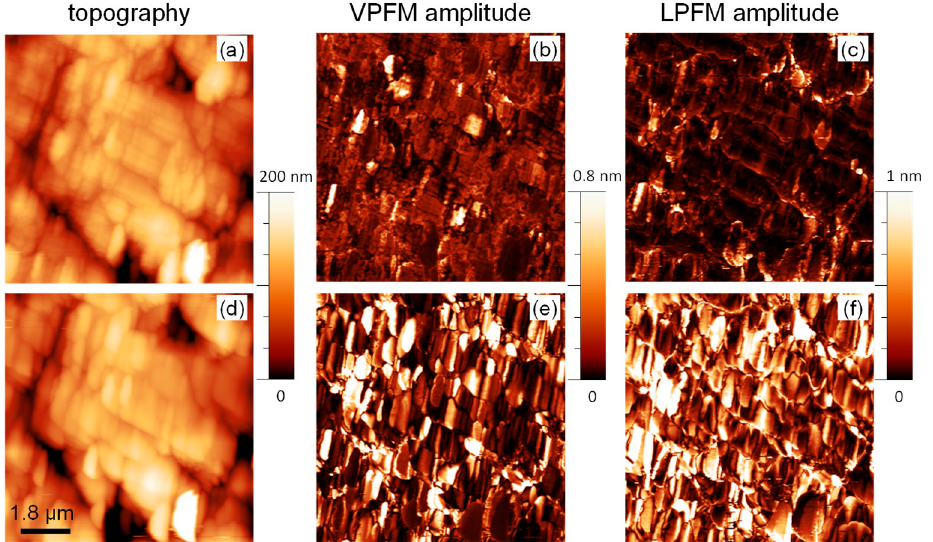
Figure 7. Topography ( a , d ), vertical PFM amplitude ( b , e ), and lateral PFM amplitude ( c , f ) images of the 0.45BMT–0.55BZT ceramics before ( a – c ) and after annealing ( d – f ).